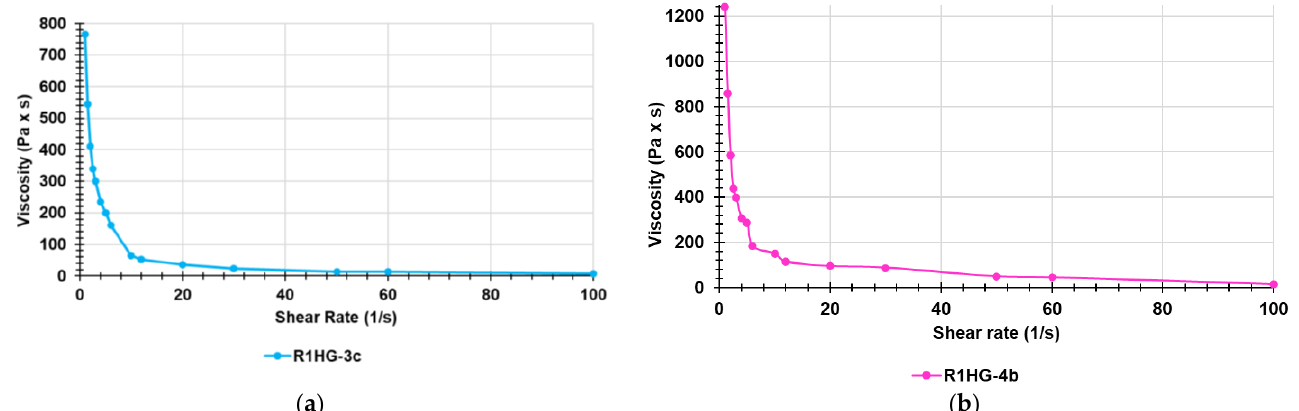
Figure 15. Curve of the viscosity vs. shear rate of R1HG-3c ( a ) and R1HG-4b ( b